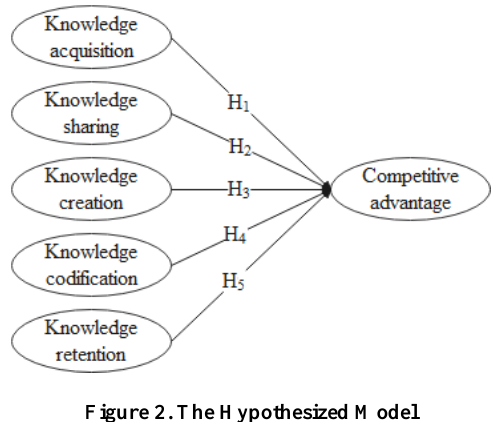
Figure 2. The Hypothesized